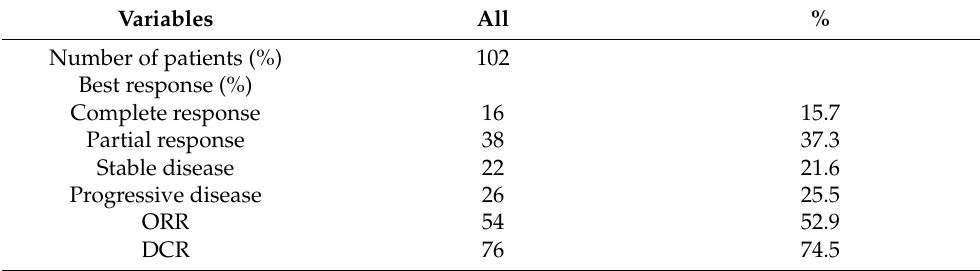
Table 2. Effectiveness of immune checkpoint inhibitor therapy .